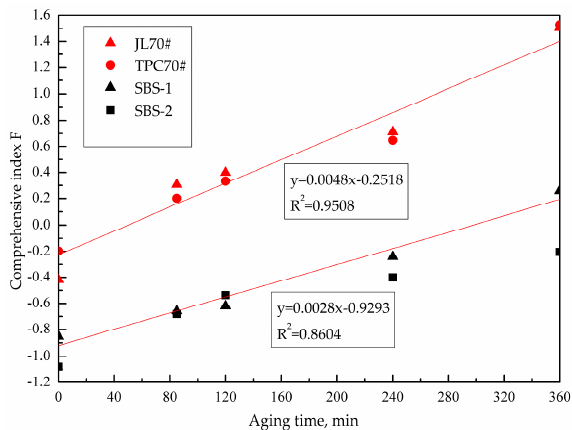
Figure 9. The linear relationship between F and aging time.